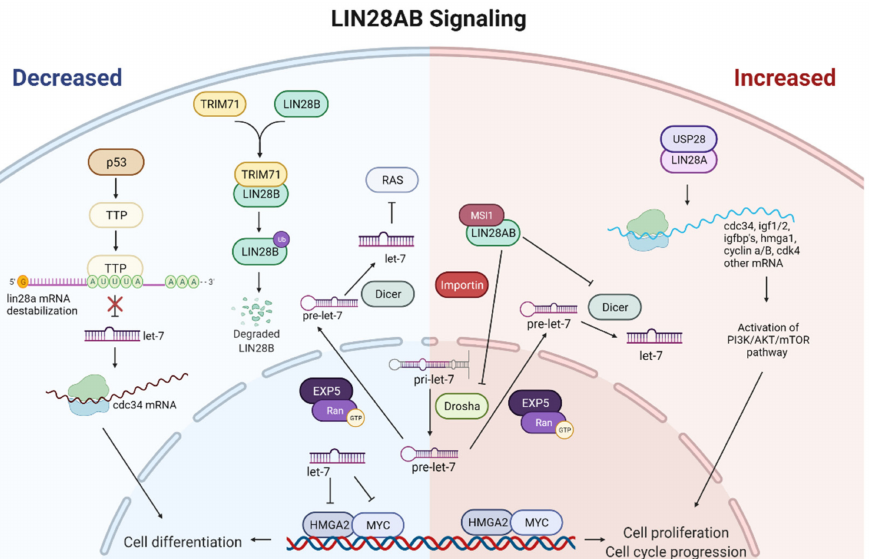
Figure 3. Schematic representation of the main LIN28A and LIN28B signaling. The left panel of the figure shows the cellular effect of decreased LIN28AB. If LIN28A/B are blocked with upstream regulators, biogenesis of let-7 miRNAs proceeded normally. High levels of let-7 will target and reduce the expression of proliferation-associated genes, driving the cells towards differentiation. The right panel of the figure shows the cellular effect of increased LIN28AB. LIN28AB represses the biogenesis of let-7 miRNAs by binding pri-let-7 and pre-let-7 and inhibiting their processing into mature let-7. Due to the low let-7 level, increased expression of proliferation-associated genes can be expected, leading to increased cell proliferation. Red arrows indicate upregulation, and green arrows indicate downregulation. Figure created with BioRender.com (accessed on 4 May